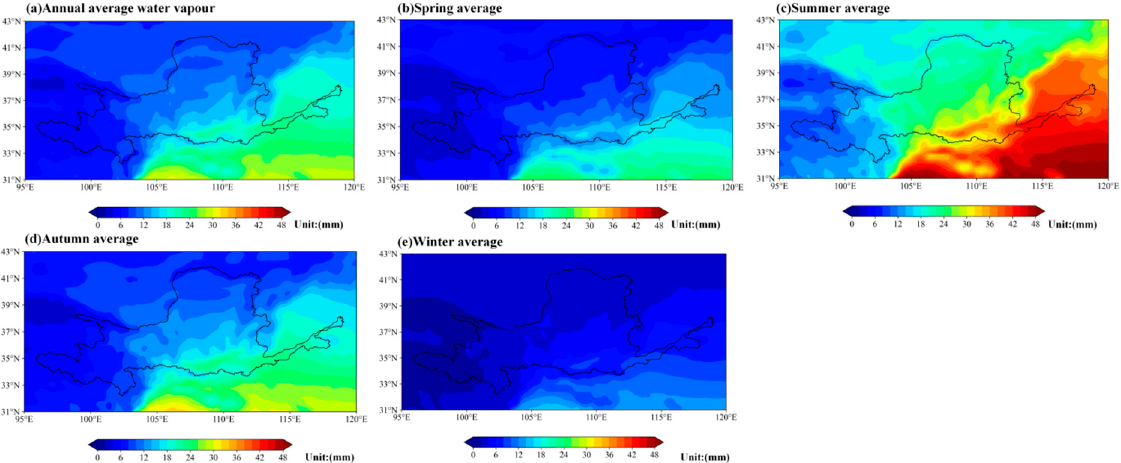
Figure 2. Annual average and seasonal average distribution of water vapor content in the Yellow River Basin from 1980 to 2019.(( a ): Annual average water vapour; ( b ): Spring average water vapour; ( c ): Summer average water vapour; ( d ): Autumn average water vapour; ( e ): Winter average water vapour.)